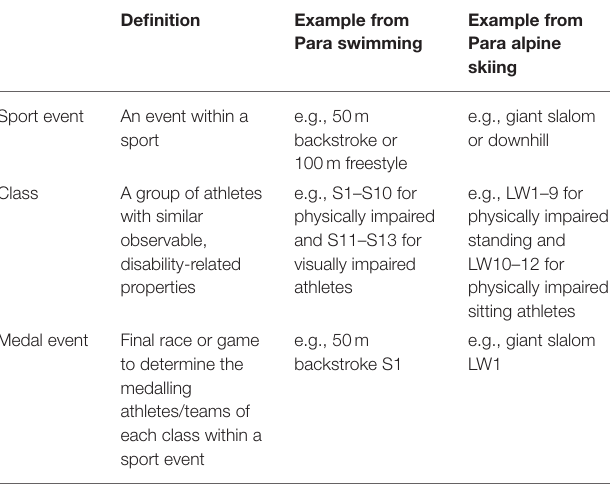
TABLE 1 | Definitions of the terms “medal event”, “sport event,” and